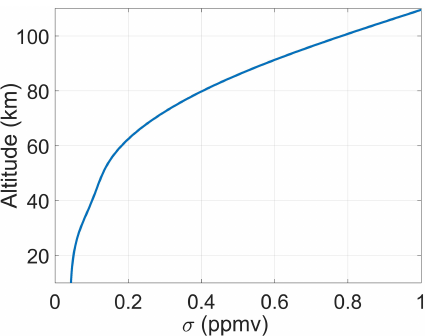
Figure 5. The value of σ i used to compute the a priori covariance matrix as a function of altitude (Eq.